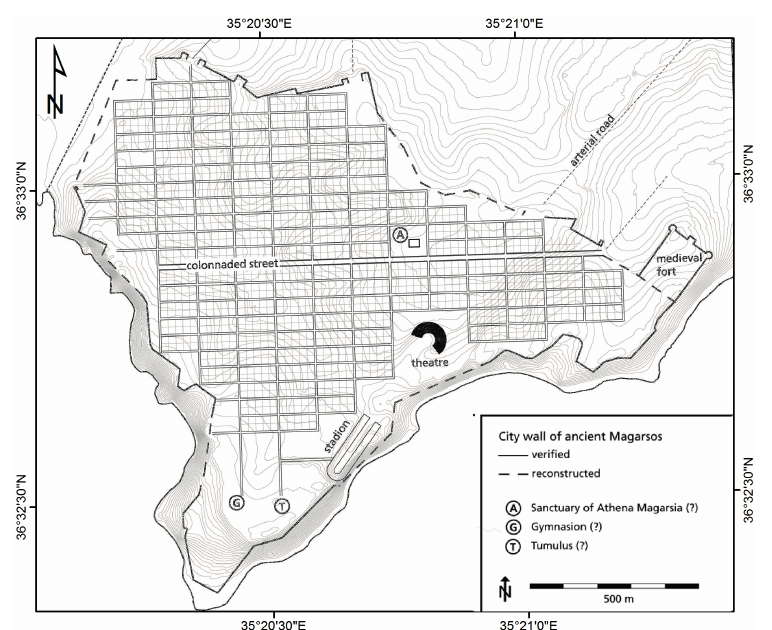
Figure 5. Overview of the settlement area of Magarsos (Cape Karata ş ) during the 2nd settlement phase (2nd century